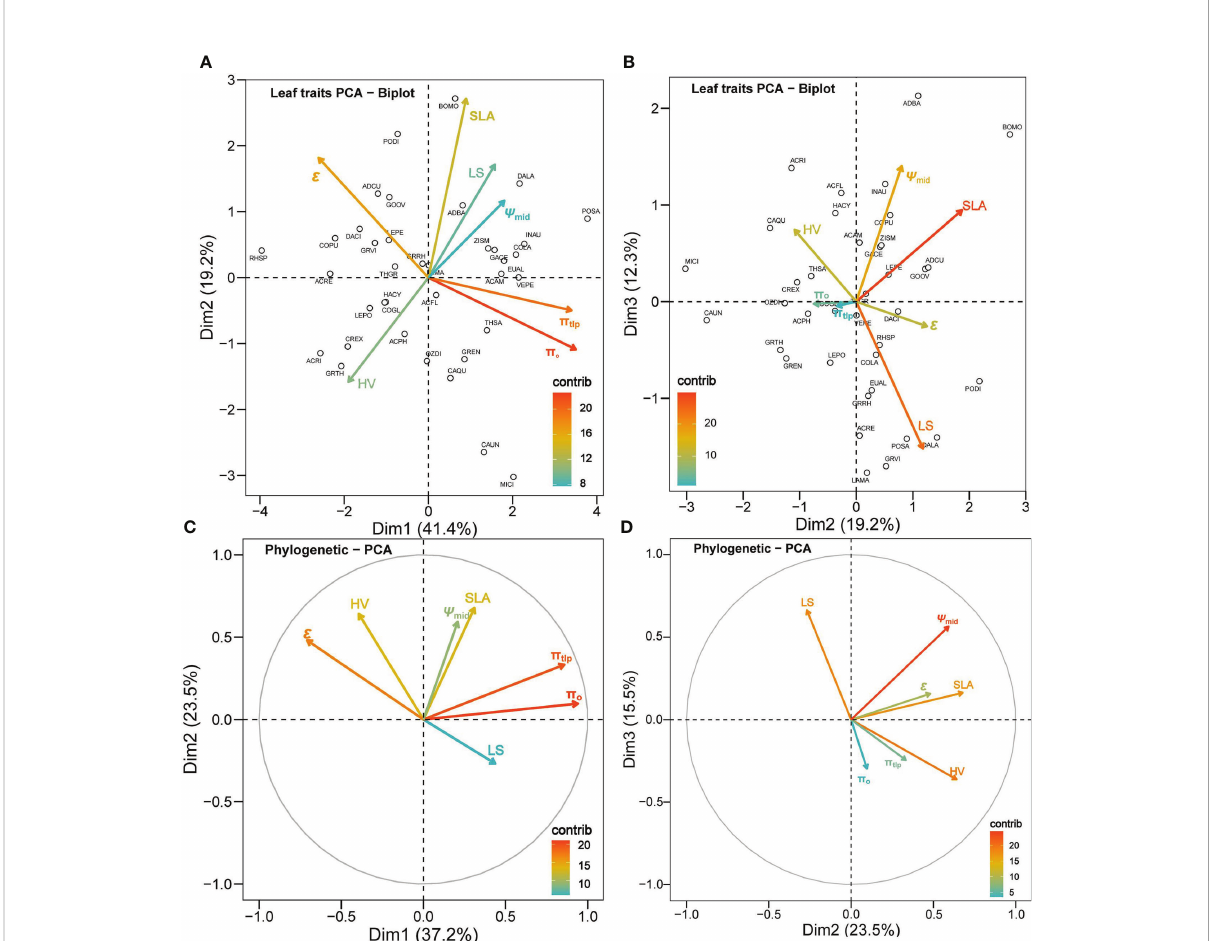
FIGURE 4 Principal component analysis (PCA) for the seven leaf traits of 37 shrub species. Panels (A, B) are not correcting for phylogeny, while (C, D) are a phylogenetically corrected PCA. The color gradients of the legend in each panel show the contribution of a trait to a given principal component in percentage. The hollow circles labeled with a four-letter species code aside in panels (A, B) represent each plant species (see supp. table 1 for full species names and corresponding species